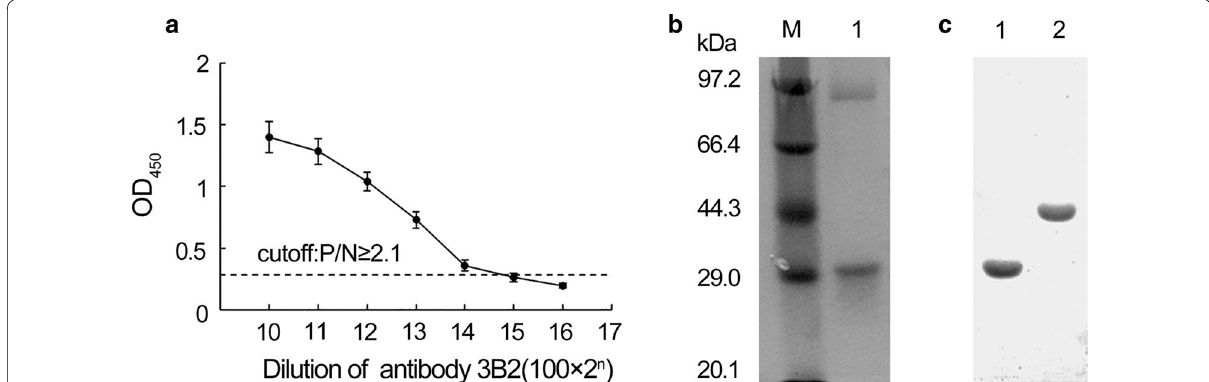
Fig. 2 Preparation of anti-dTMP-GH monoclonal antibody 3B2. a Titer detection of the monoclonal antibody 3B2. b Purity detection of the mono- clonal antibody 3B2. Lane M protein molecular weight markers; lane 1 purified monoclonal antibody 3B2. c Reactivity of monoclonal antibody 3B2. Lane 1 dTMP-GH; lane 2